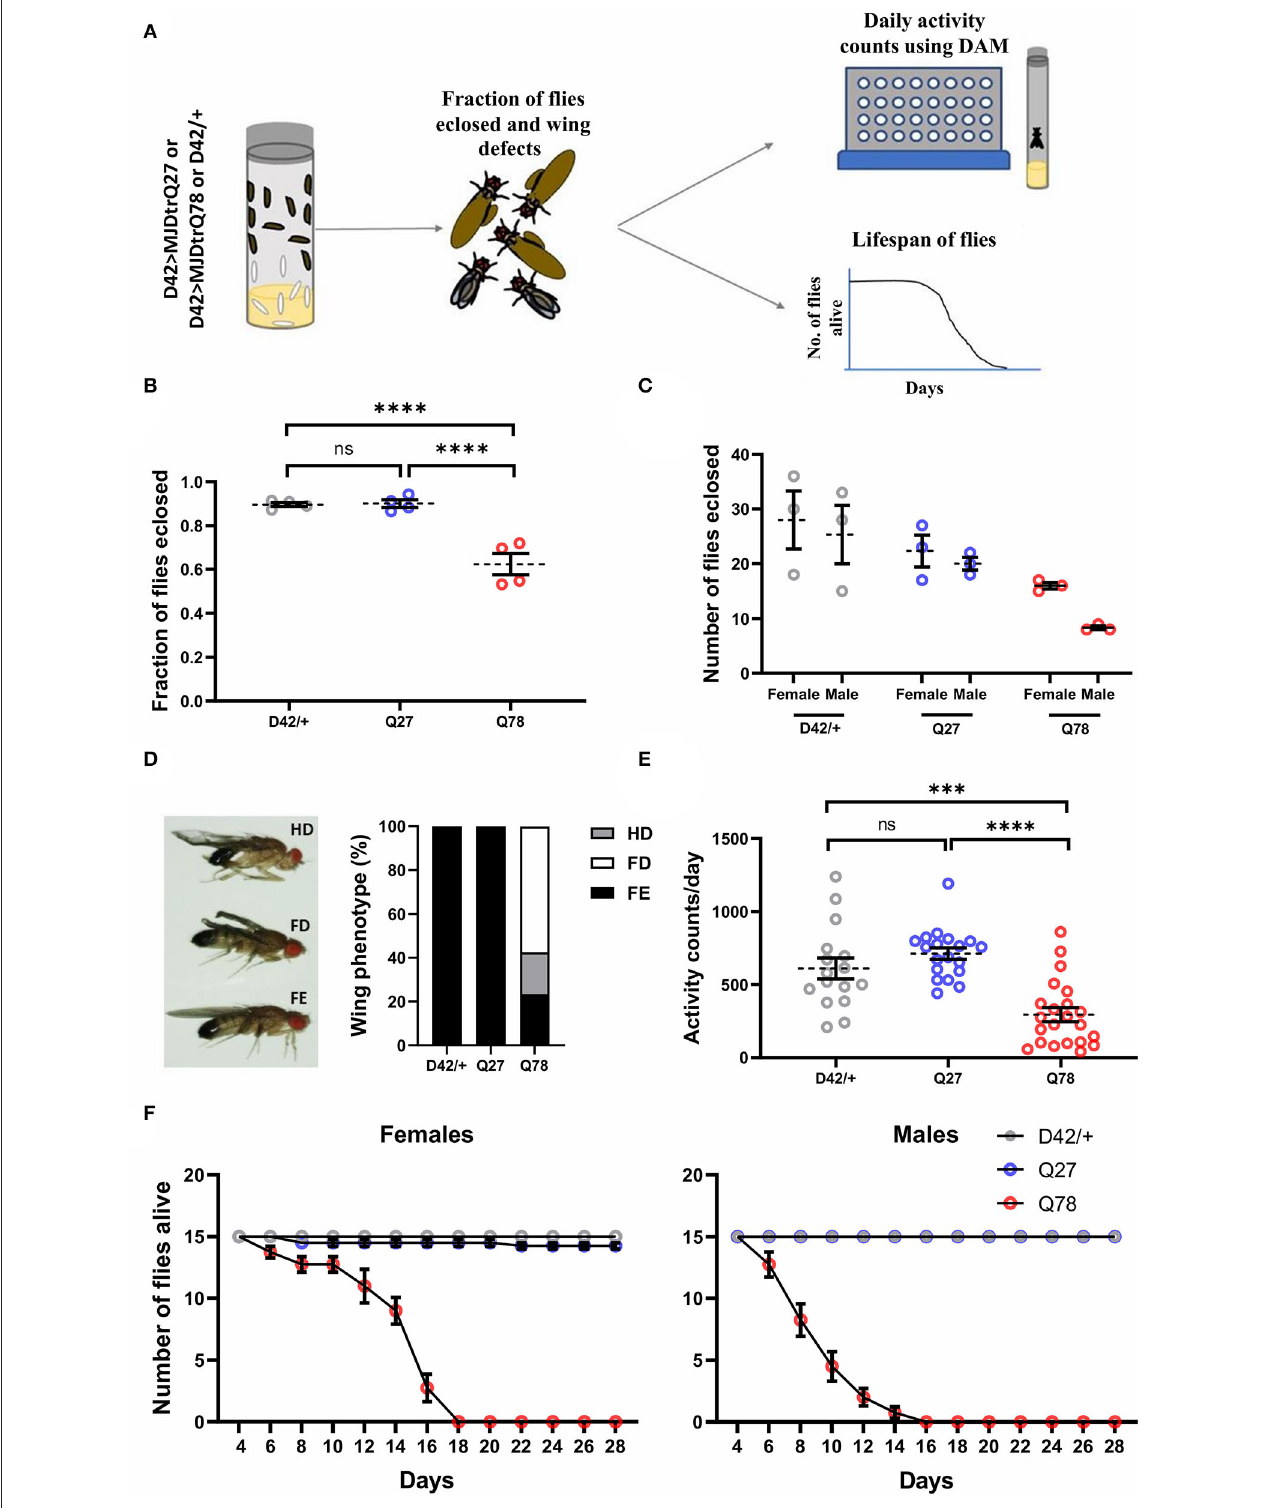
FIGURE 2 | Eclosion, locomotion, and lifespan are affected in adult flies on the expression of Q78 in motor neurons. (A) A flow chart depicting phenotypes characterized in adult flies expressing non-pathogenic Q27 or pathogenic Q78 in motor neurons using the D42-Gal4 driver. A fraction of adult flies that successfully emerged from pupae, wing phenotypes, locomotion, and adult lifespan was assayed. (B) Quantification of fraction of flies eclosed. n > 280 pupae from 4 vials; 3x2